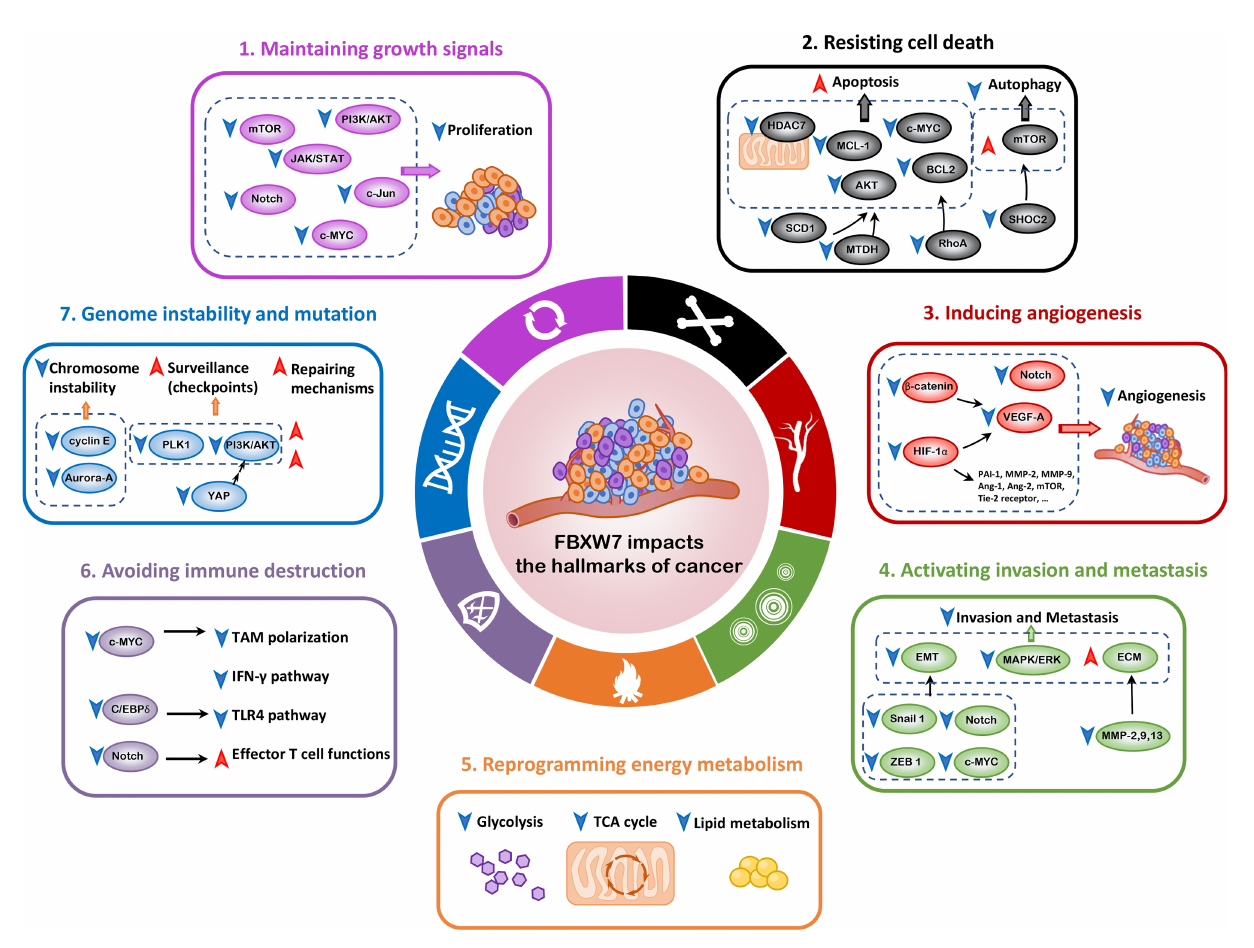
FIGURE 2 | FBXW7 and the hallmarks of cancer. In this review, we mainly elaborate on seven hallmarks of cancer in fl uenced by FBXW7, including maintaining growth signals, resisting cell death, inducing angiogenesis, activating invasion and metastasis, reprogramming energy metabolism, avoiding immune destruction, and genome instability and mutation. Ang-1, Angioprotein-1; BCL2, B cell lymphoma 2; C/EBP d , CCAAT/enhancer binding protein d ; ECM, extracellular matrix; EMT, epithelial – mesenchymal transition; HDAC7, histone deacetylase 7; HIF-1 a , hypoxia-inducible factor-1 a ; ICL, interstrand cross-link; MAPK/ERK, mitogen-activated protein kinase/extracellular signal – regulated kinase; MCL-1, myeloid cell leukemia-1; MMP, matrix metalloproteinase; MTDH, metadherin; NHEJ, nonhomologous end-joining; PAI-1, plasminogen activator inhibitor-1; PLK1, polo-like kinase 1; SCD1, stearoyl-CoA desaturase 1; VEGF-A, vascular endothelial growth factor-A; YAP, Yes-associated protein; ZEB1, zinc- fi nger E-box-binding homeobox